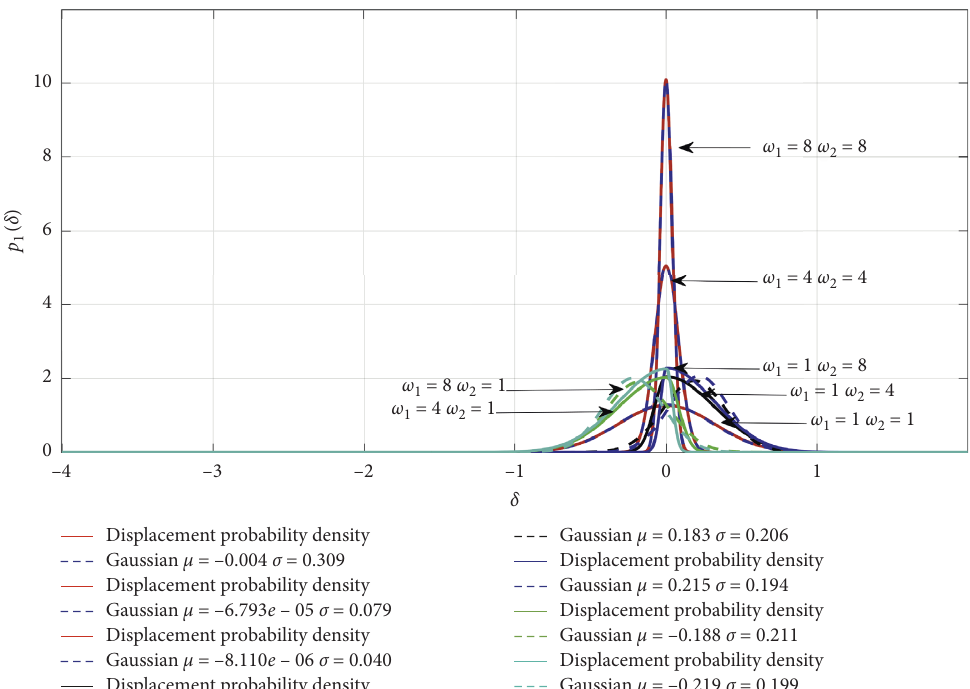
Figure 8: Displacement PDFs of ATNPS for various values of initial angular frequencies.